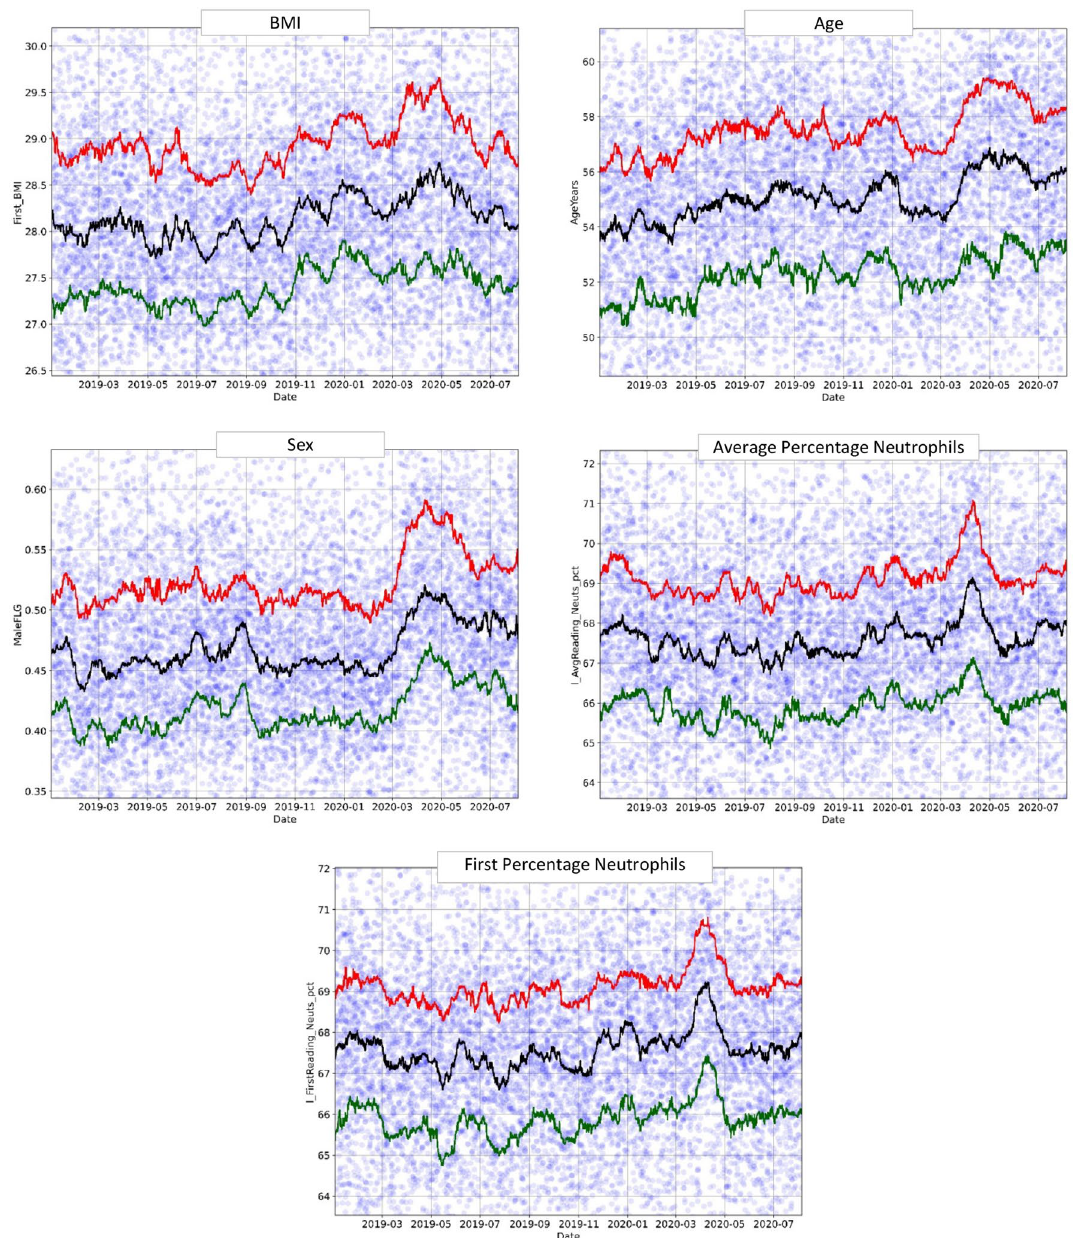
Figure 4. BMI, age, sex, and neutrophil percentage model features plotted over time (January 2019–August 2020). The circles represent the original data averaged over 6-h intervals, and the lines-moving percentile curves for 25%, 50%, and